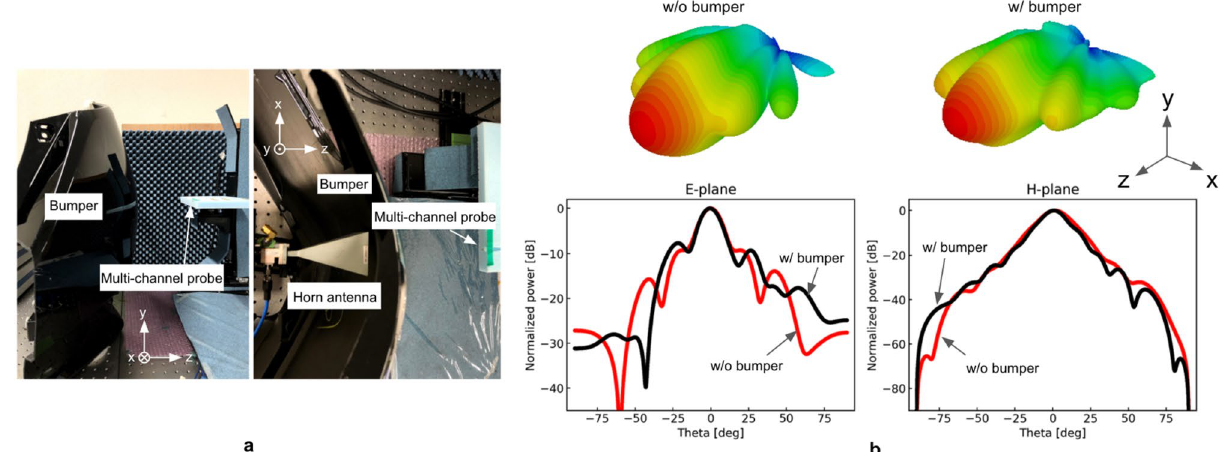
Figure 5. Far-field characterization of the horn antenna with and without a car bumper. ( a ) Experimental situation. A car bumper is installed just in front of the horn antenna. ( b ) 1D and 2D radiation patterns with and without the